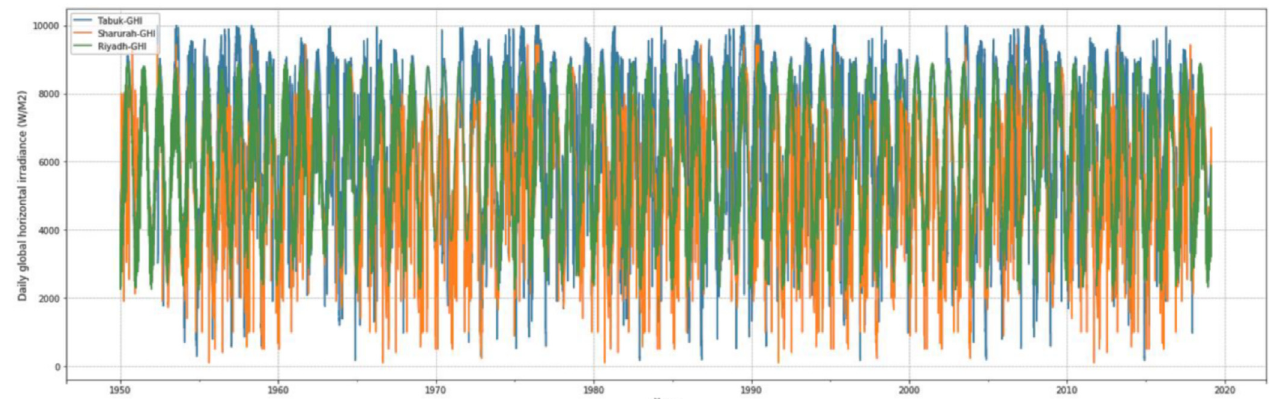
Fig. 5. The global horizontal irradiance (GHI) performance of the three regions from 1950 to 2020 [9]. The lowest line is 0 Wm (cid:1) 2 and the highest line is 1000 Wm (cid:1) 2 . The highest GHI is in Riyadh and Tabuk and the lowest is in